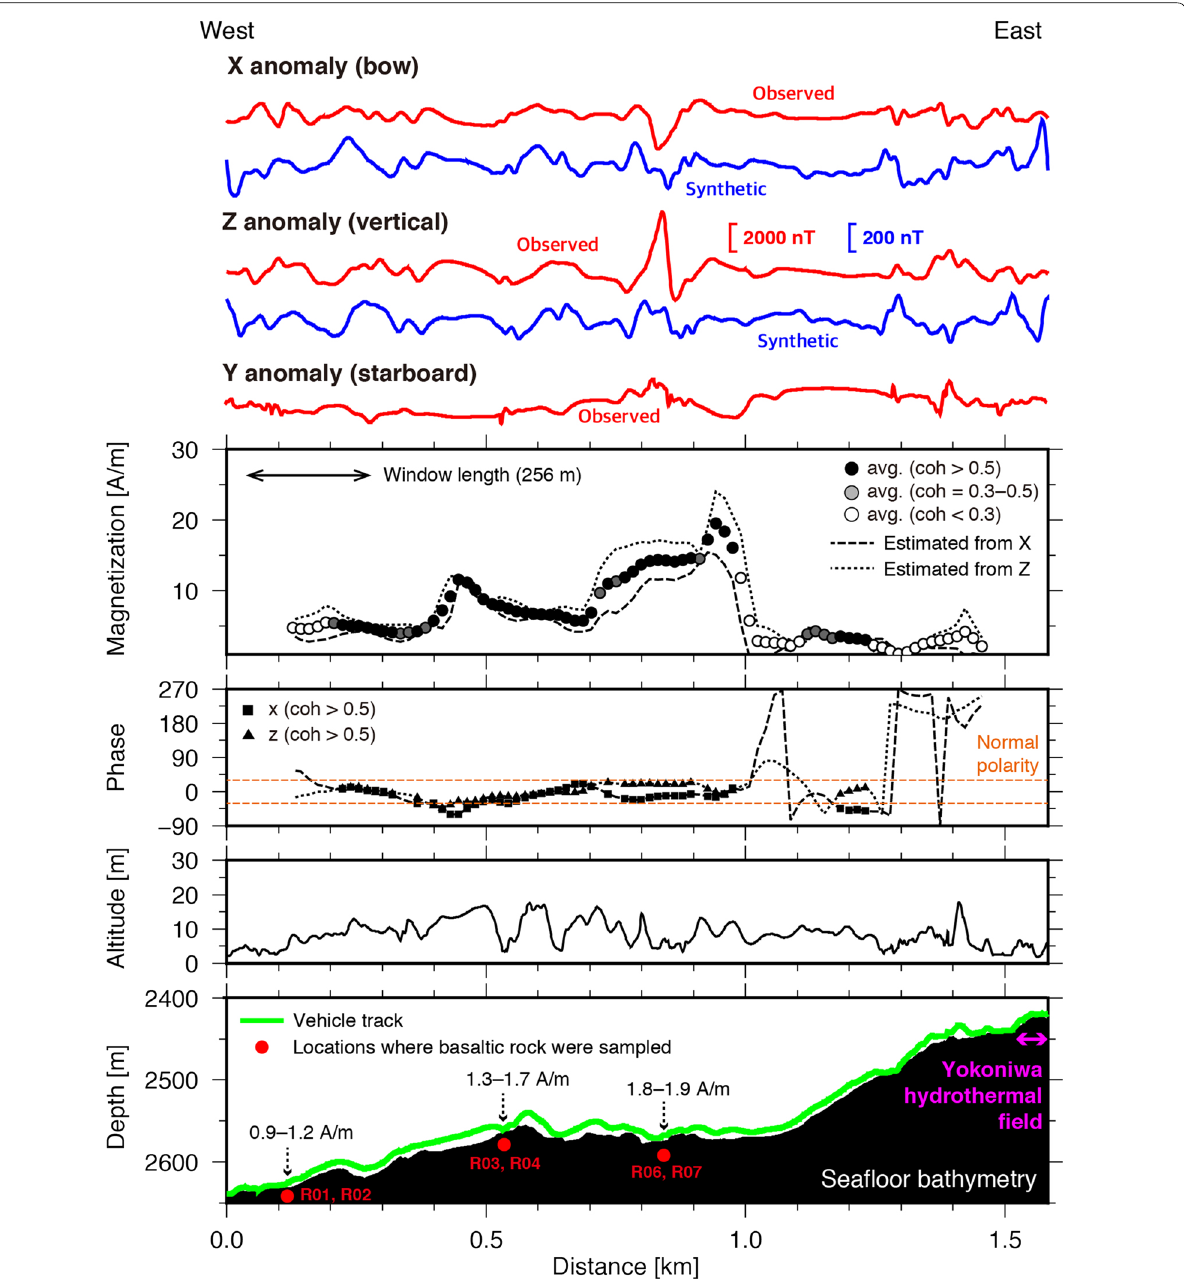
Fig. 5 Analysis x (bow) and z (downward) components of observed magnetic anomaly along the 6K#1331 track (reanalyzed after Fujii et al. 2016a). From top to bottom: observed (red line) and synthetic (blue line) magnetic anomaly intensity, magnetization, phase, vehicle altitude, and seafloor/ vehicle geometry. Black and gray circles are those with high coherency of > 0.5 and from 0.3 to 0.5 on both the x and z components, respectively. The locations of the Yokoniwa hydrothermal field and collected basaltic rock samples are shown in the bottom figure. Magnetic and physical properties for lava samples of 1331R01, 1331R02, 1331R03, 1331R04, 1331R06, and 1331R07 are shown in Table